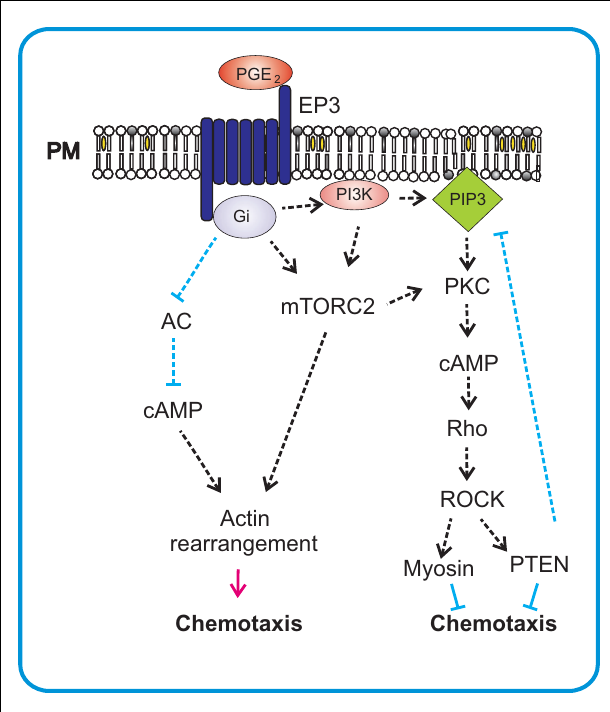
FIGURE 5 | PGE 2 -mediated chemotaxis. PGE 2 mediates its chemotactic action on mast cells via Gi-coupled EP3 receptor. After activation the α -subunit of G-protein inhibits adenylate cyclase (AC) and thereby causes a decrease of cAMP which leads to stimulation of migration.This stimulation also results in activation of mTORC2, an important regulator of actin rearrangements and positive regulator of chemotaxis. mTORC2 can also influence PKC-dependent activation of small GTPase Rho and subsequent activation of PTEN through ROCK. This can act as a negative feedback for production of PIP3 by PI3K that is also activated by PGE 2 in mast